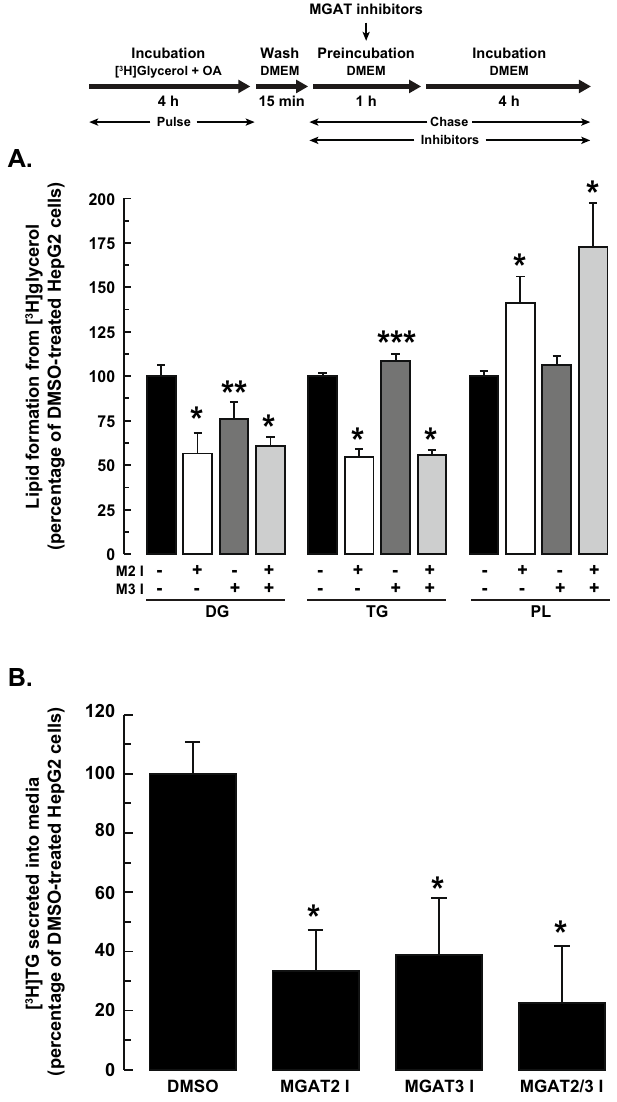
Figure 6. MGAT2 contributes to TG re-esterification. HepG2 cells were incubated with DMEM containing 5 µCi [ 3 H]glycerol and 0.25 mM oleic acid for 4 h. The radioactivity was washed away, and cells were then incubated with the MGAT inhibitors, separately or together. After 1 h, the media was replaced with fresh DMEM (containing MGAT inhibitors) and incubated for another 4 h. The incorporation of radioactivity into ( A ) intracellular lipids (TG, DG and PL) and ( B ) secreted TG was then determined. Values for DMSO-treated controls: DG (3.6 × 10 3 dpm/mg cell protein), TG (82.0 × 10 3 dpm/mg cell protein), PL (57.2 × 10 3 dpm/mg cell protein), secreted TG (0.90 × 10 3 dpm/mg cell protein). * p < 0.001 versus DMSO-treated cells; ** p < 0.01 versus DMSO-treated cells; *** p < 0.05 versus DMSO-treated